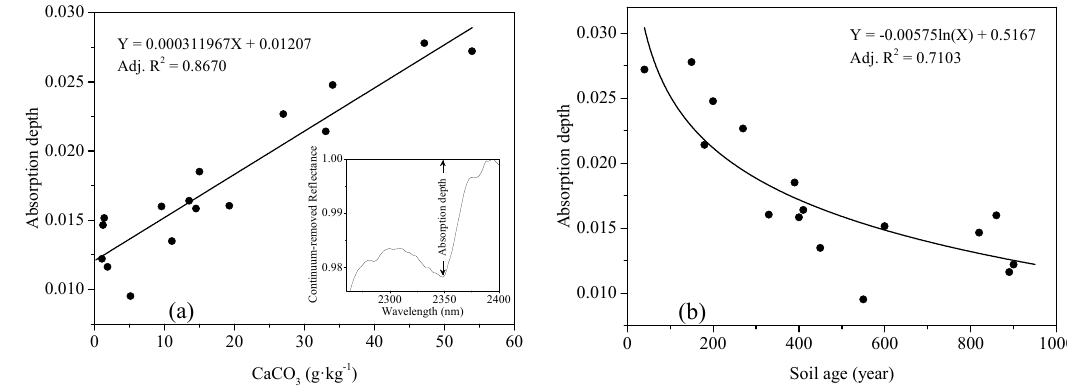
Figure 9. Changes in the absorption depth at 2345 nm with CaCO 3 and time. The absorption depth at 2345 nm increases linearly with CaCO 3 content ( a ) and decreases logarithmically with soil age ( b ).